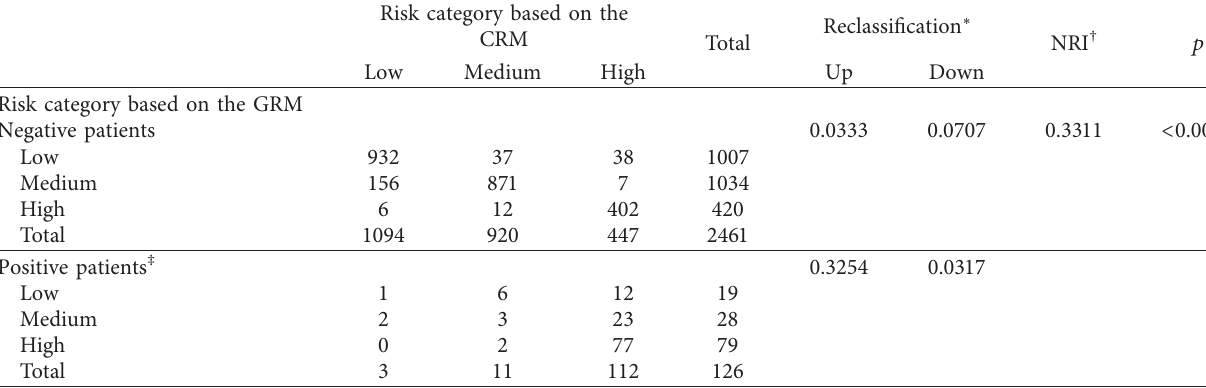
Table 2: Reclassification table comparing the CRM to GRM.